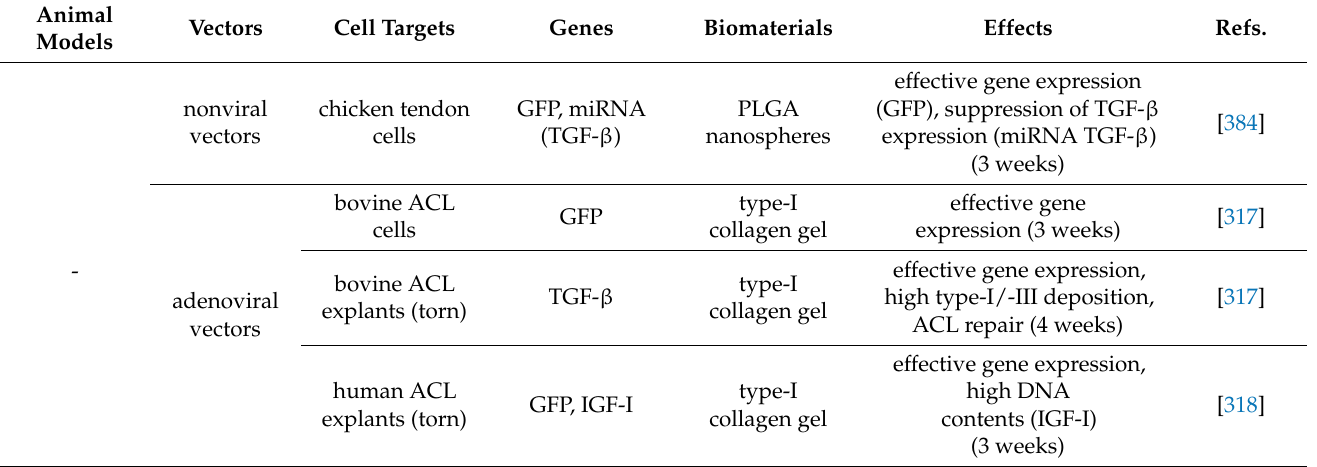
Table 6. Applications of biomaterial-guided gene therapy for ACL